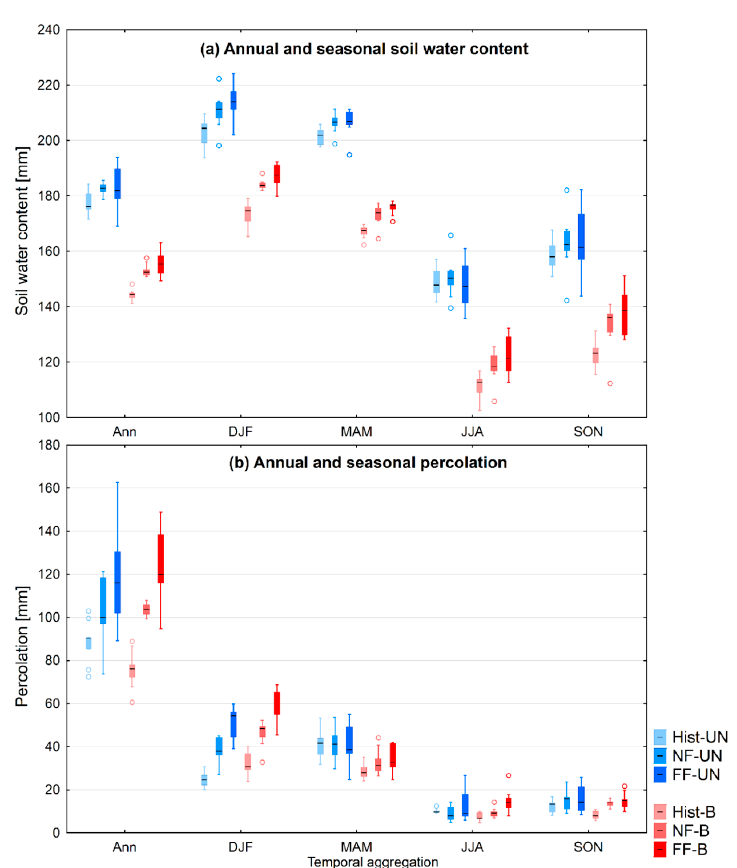
Figure 8. Multi-model ensemble projections of annual and seasonal soil water content ( a ) and percolation ( b ) for the near (NF) and the far (FF) future under RCP 4.5 in comparison to the historical (Hist) period. B stands for the Barycz catchment and UN stands for the Upper Narew catchment.